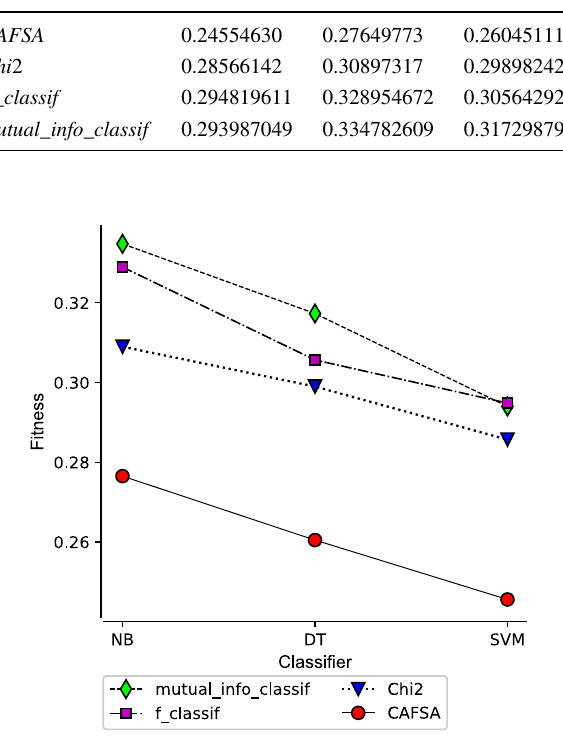
Fig. 12 Chi-square test and CAFSA performance on SoGouCS news data